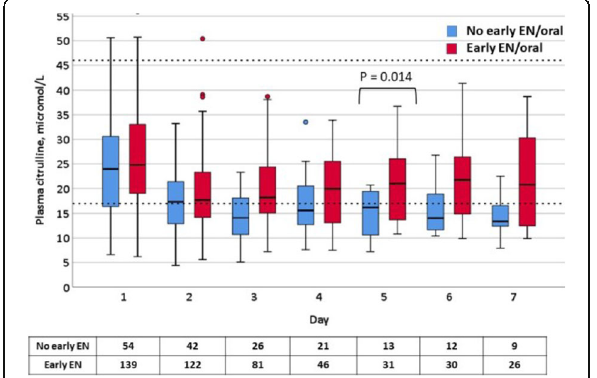
Fig. 4 (abstract 000298). Plasma citrulline in patients with successfull (80% of caloric goal reached by day 4) vs unsuccessful